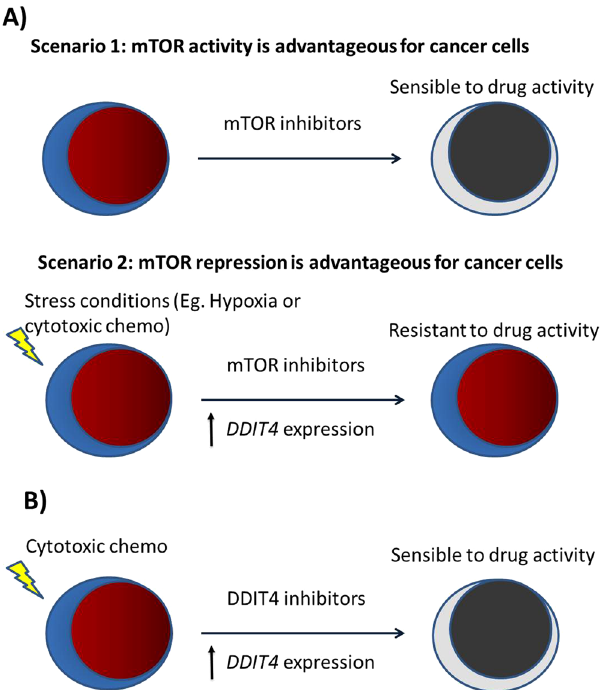
Figure 9. Proposed scenarios of DDIT4 activity. ( A ) Efficacy of mTOR inhibitors depends of the context or “scenario” according to status of activation/repression of mTOR. Resitance to mTOR inhibitors could be explained by the advantageous situation when DDIT4 repress tumor cells under stress conditions. ( B ) Overcome of resistance could be achieved with combination of cytotoxic chemotherapy and DDIT4